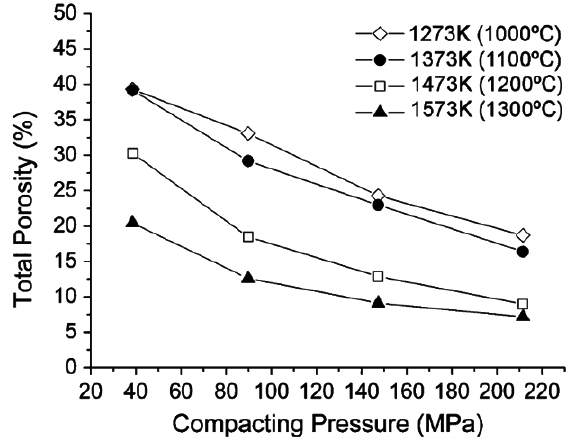
Figure 17. Total porosity behavior as a function of both compacting pressure and sintering temperature [222]. Reprinted with permission from [222]. Copyright 2011